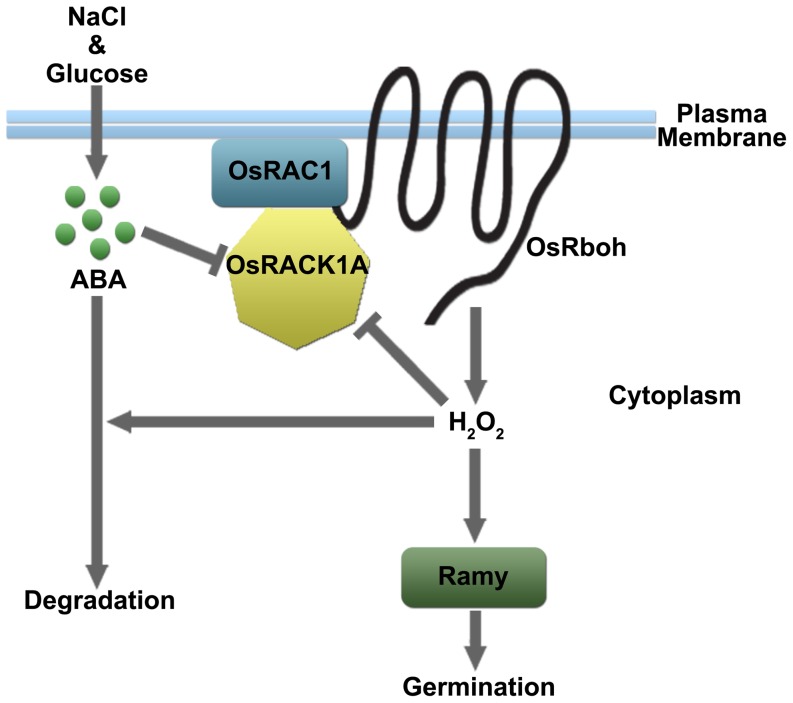
A working model showing proposed molecular steps of OsRACK1A-mediated signal transduction pathway.This model presents a schematic of OsRACK1A and other signal molecules involved in the proposed signal transduction pathway during seed germination. The results presented in this work combined with the results reported by Nakashima et al. (2008) to support this signal transduction. Under normal germination conditions, cytosol OsRACK1A moved towards plasma membrane and interacted with OsRAC1 to form a complex. The formed complex then activated downstream OsRboh, and as a result, stimulated H2O2 production and seed germination. When responding to external stimuli, which may induce ABA accumulation (Figure S4; Zhu et al, 2009), excess ABA inhibited OsRACK1 expression and blocked the formation of OsRACK1A-OsRAC1 complex, and as a consequence, suppressed the expression of OsRbohs and the production of H2O2 (Figure 5). Excess H2O2 in return suppressed OsRACK1 expression to avoid its hazardous effect (Figure S5). In addition, H2O2 may also stimulate ABA catabolism and alleviated the inhibitory effect on seed germination.